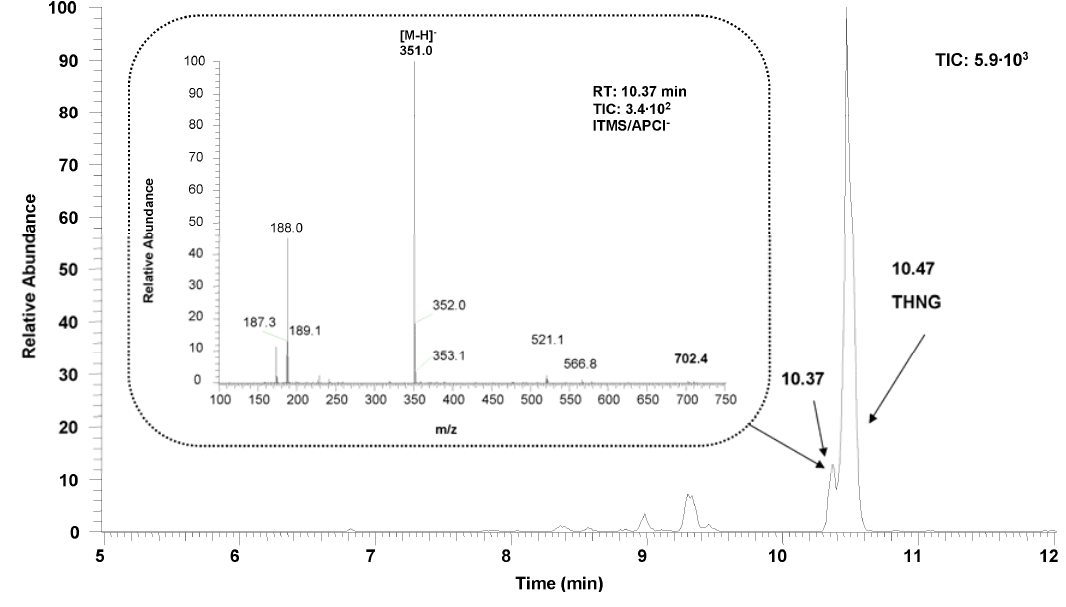
Figure 2. Chromatographic profile of the Impatiens glandulifera Royle methanolic extract of the roots measured as total ion current (TIC) by LC-MS (APCI). MS spectrum of THNG is shown on the Figure